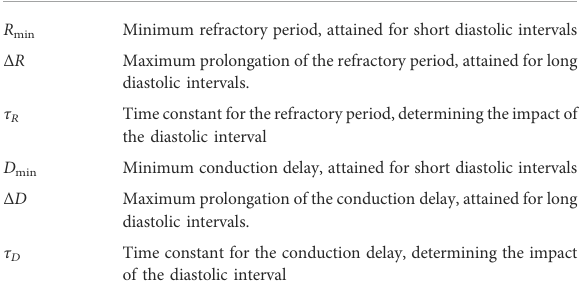
TABLE 1 The interpretation of the model parameters. Superscripts indicating the pathway (SP, FP) are omitted to avoid redundancy. Parameter Parameter